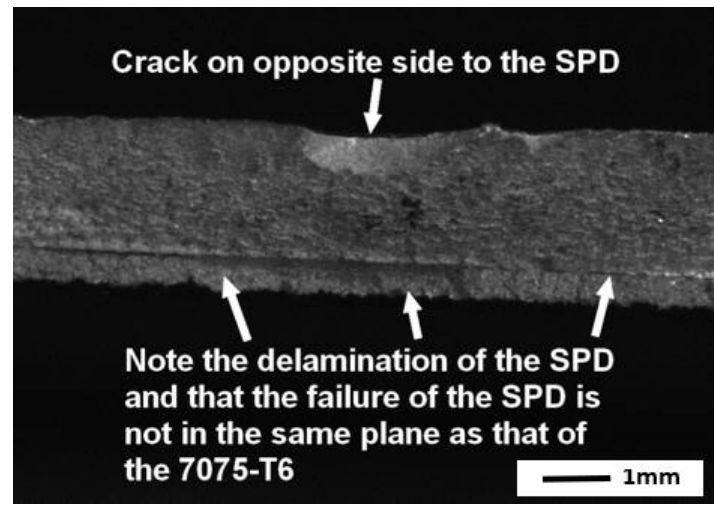
Figure 21. Close-up view of cracking on the side opposite to the repair/coating, and subsequent delamination both between the coating and the 7075-T6 substrate.